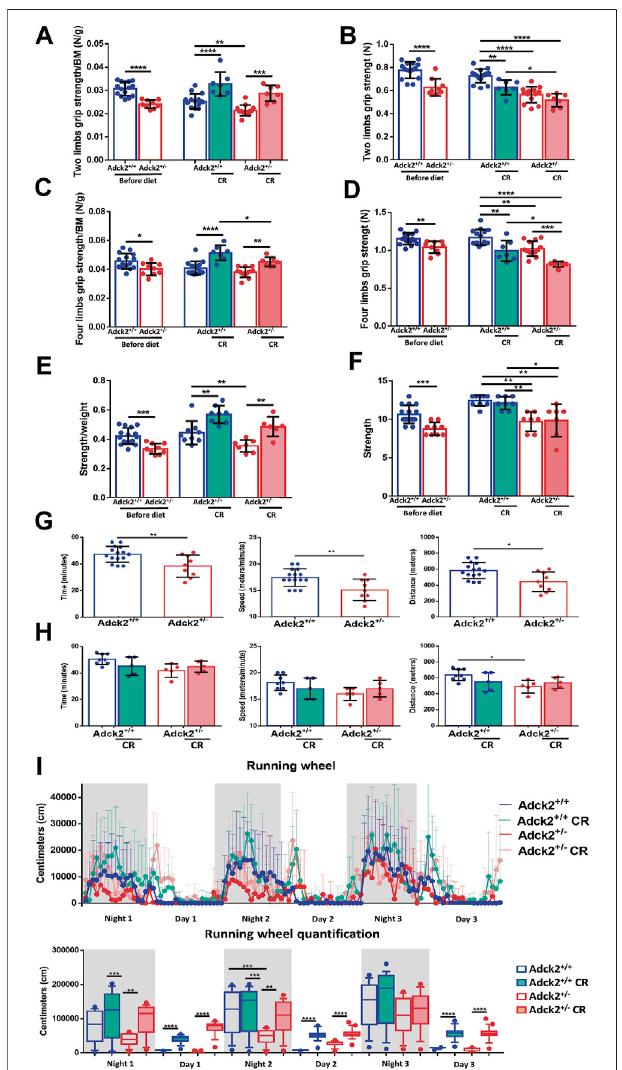
FIGURE 3 | Calorie restriction adaptations on physical performance. Results for two and four limbs grip strength tests, weight-lifting normalized by body weight and aerobic treadmill tests are shown on basal conditions before starting and at end of diet periods (A,C,E,G,H) . Two and four limbs grip strength tests and weight-lifting test without normalization (B,D,F) . (I) Voluntary wheel running activity in the automated home cage phenotyping system. Data are expressed as distance recorded in centimeters (cm). CR, calorie restriction; BM, body mass. In all cases, data represent the mean ± SD. A, B, C y D (before diet Adck2 +/+ N = 15, Adck2 +/ − N = 9. After diet Adck2 +/+ N = 15, Adck2 +/ − N = 13 Adck2 +/+ CR N = 7, Adck2 +/ − CR N = 7). E and F (before diet Adck2 +/+ N = 15, Adck2 N +/ − = 9. After diet Adck2 +/+ N = 9, Adck2 +/ − N = 7 Adck2 +/+ CR N = 8, Adck2 +/ − CR N = 7). G (Adck2 +/+ N = 16, Adck2 +/ − N = 9). H (Adck2 +/+ N =8,Adck2 +/ − N=5Adck2 +/+ CRN=5,Adck2 +/ − CRN=5).I(Adck2 +/+ N= 7, Adck2 +/ − , N = 5 Adck2 +/+ CR N = 7, Adck2 +/ − CR N = 8). One-way ANOVA test was applied. * p < 0.05; ** p < 0.01; *** p < 0.001; **** p < 0.0001. Regression-based analysis of absolute strength using body mass as covariate (ANCOVA) was also applied to the strength tests without normalization by body mass (B,D,F) giving the following p -values: 0,0000025 (B, two limbs grip strength test), 0,0045 (D, four limbs grip strength test) and 0,00042 (F, weight-lifting